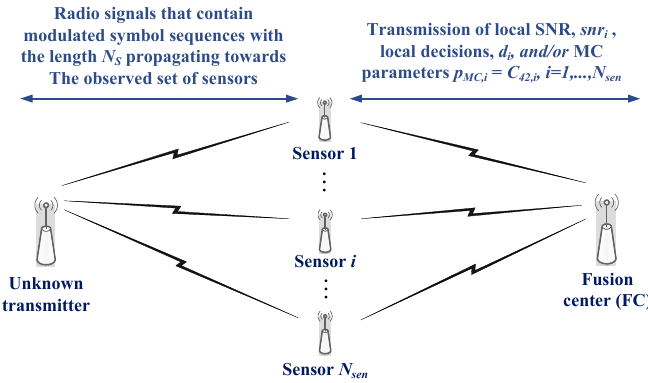
Figure 1. The general scheme of cooperative modulation classification (MC) with centralized fusion [25].